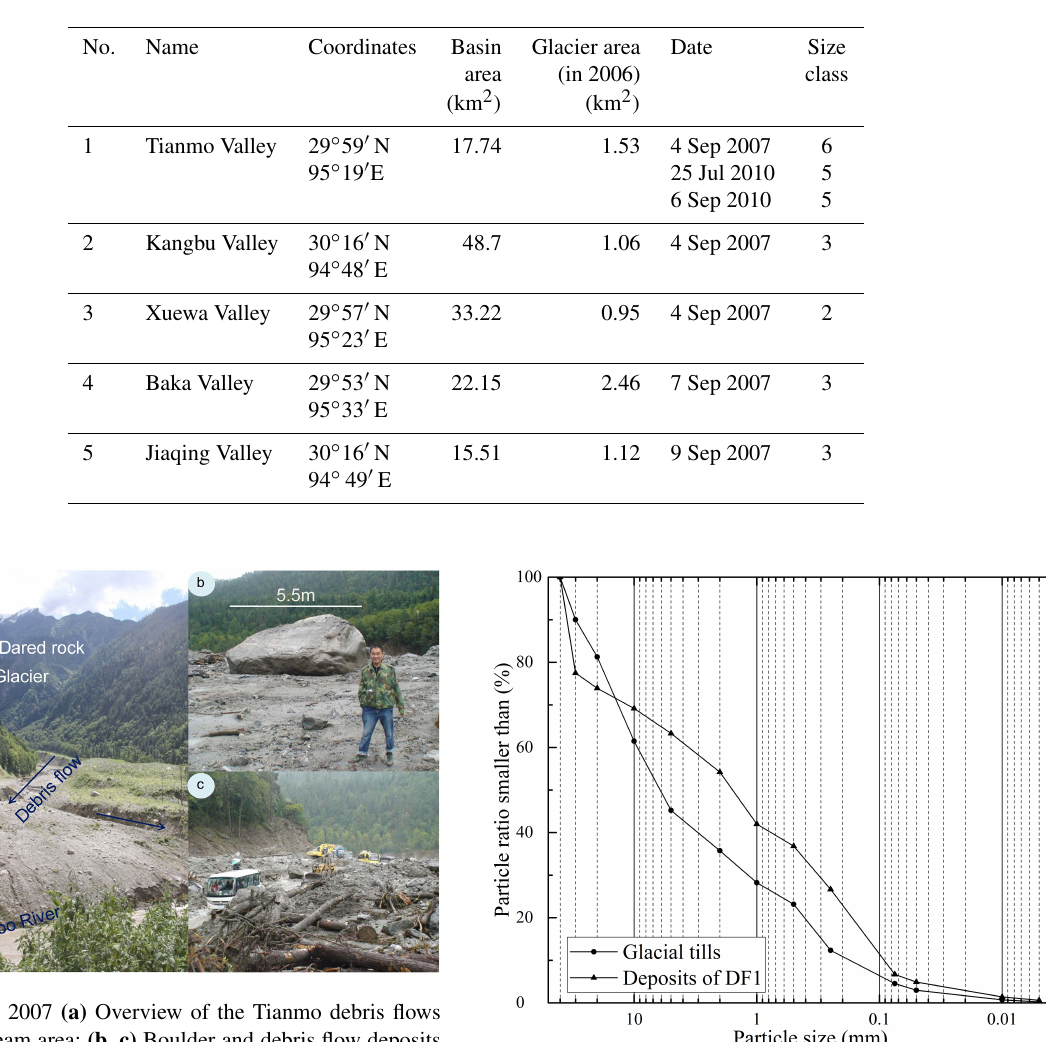
Table 2. Basic information regarding the debris flows in Tianmo Valley and nearby valleys.